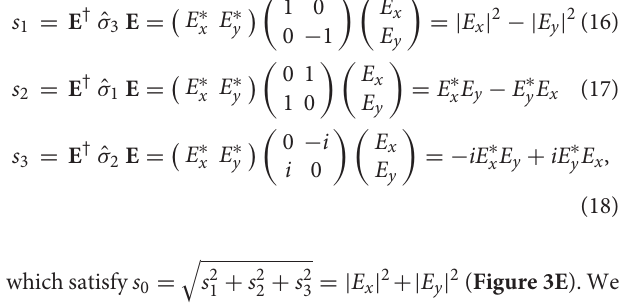
E x ) and (D) the phase ( φ y )of the horizontal electric | |